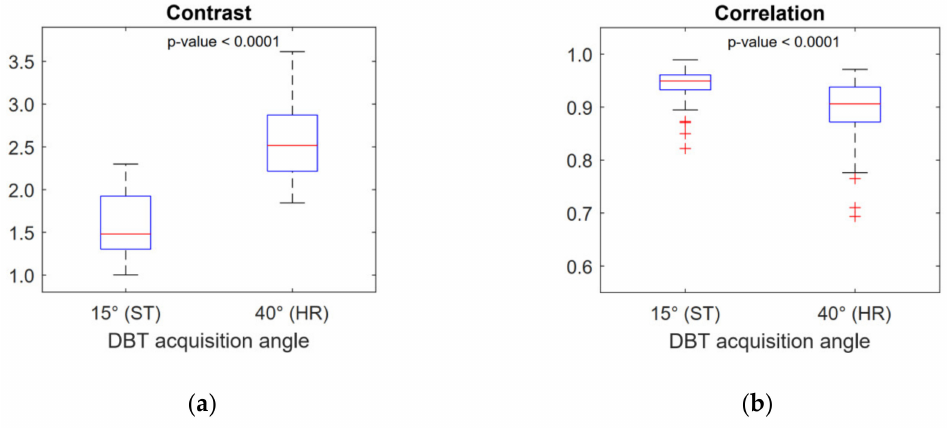
Figure 3. Boxplots of the non-correlated features Contrast ( a ) and Correlation ( b ). These features show a significant di ff erence between 15 ◦ acquisition angle (standard mode) and 40 ◦ acquisition angle (high resolution mode) DBT